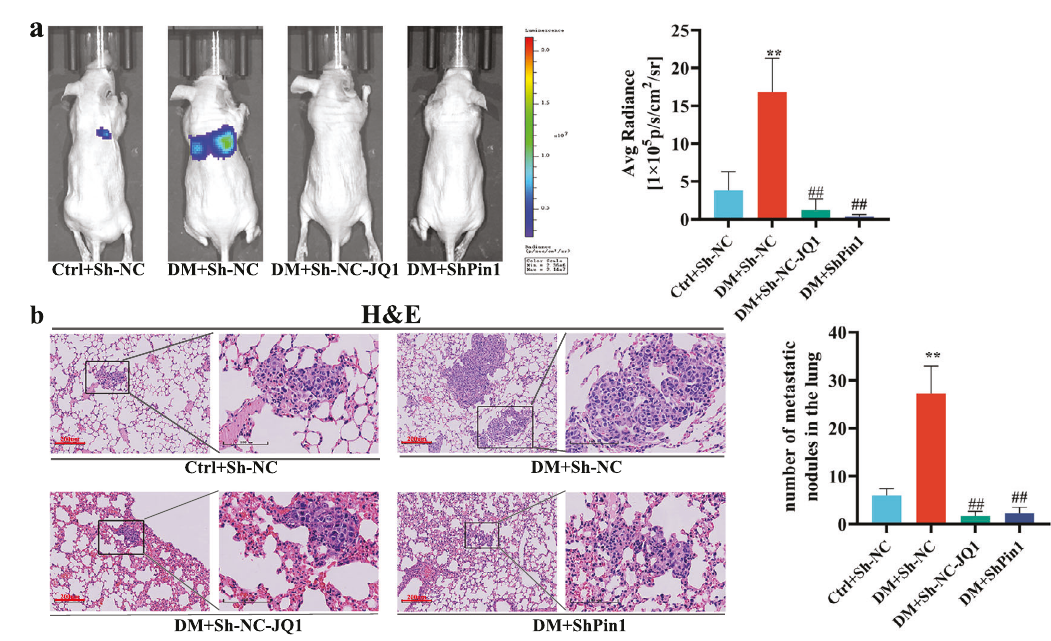
Fig. 6 Effect of Pin1/BRD4 axis on lung metastasis of GC induced by hyperglycemia. a Stable ShPin1 or Sh-NC MKN45 cells were injected into the tail vein of nude mice. In vivo tumor lung metastasis in tumor xenografts were assessed using bioluminescence imaging 24 days after injection. Lung metastases of the nude mice were quanti fi ed and measured as average radiance (p/s/cm 2 /sr). Values are mean ± SEM (n = 4); ** P < 0.01 vs. Ctrl + Sh-NC; ## P < 0.01 vs. DM + Sh-NC. b Lung tissues were stained with HE to observe lung metastasis nodules. Scale bars, 100 μ m and 200 μ m. The histogram shows the number of lung metastasis nodules. Values are mean ± SEM (n = 4). ** P < 0.01 vs. Ctrl + Sh-NC; ## P < 0.01 vs. DM +